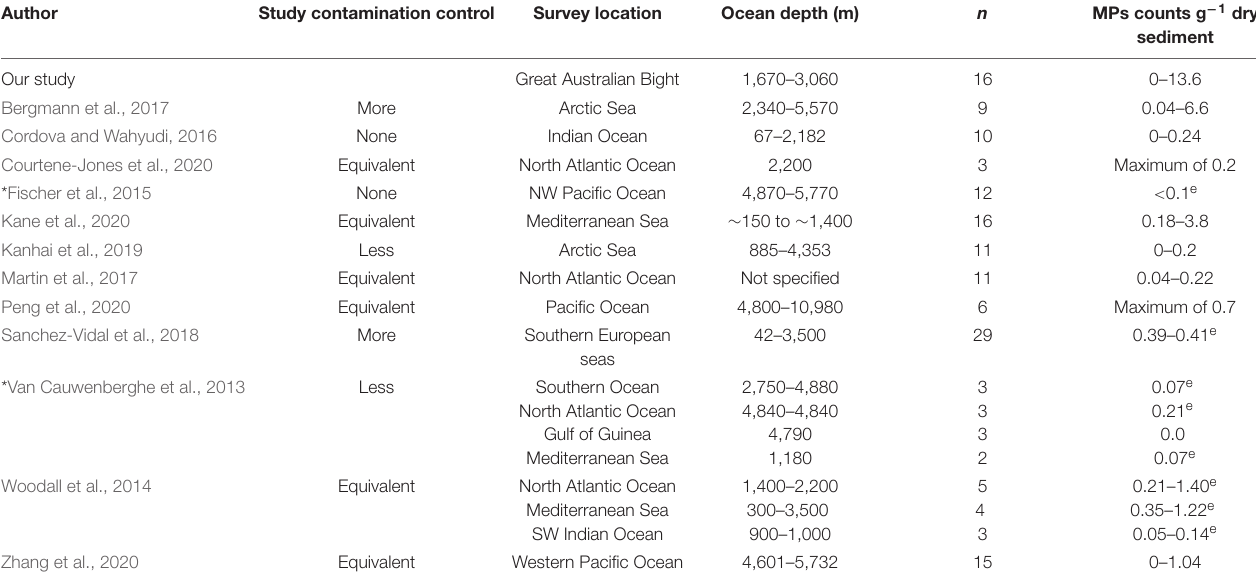
TABLE 4 | Counts from all known studies of MP in deep-sea sediment